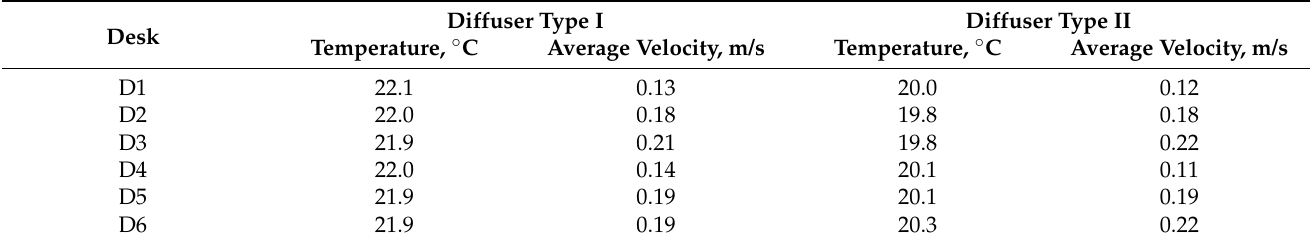
Table 1. Results of the measurements for air parameters on selected desks for air diffuser Type I and Type II.